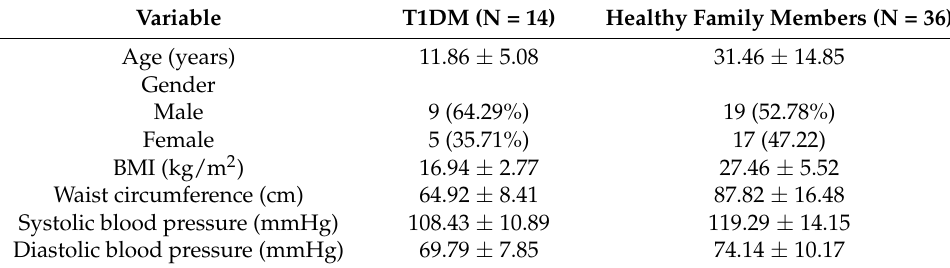
Table 1. Demographic and anthropometric data of probands and healthy family